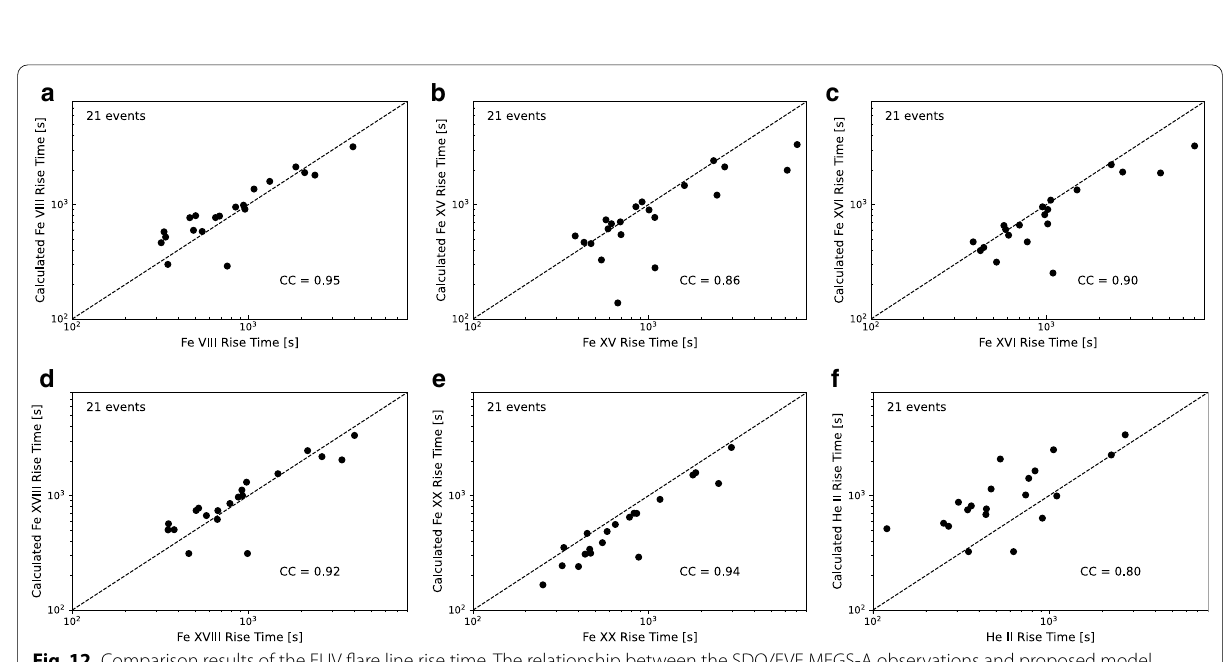
Fig. 12 Comparison results of the EUV flare line rise time. The relationship between the SDO/EVE MEGS-A observations and proposed model estimations of the EUV flare line rise time for a Fe VIII, b Fe XV, c Fe XVI, d Fe XVIII, e Fe XX, and f He II. In each panel, the dashed line indicates the straight line with slope of “1” and the correlation coefficient (CC) is shown at the bottom